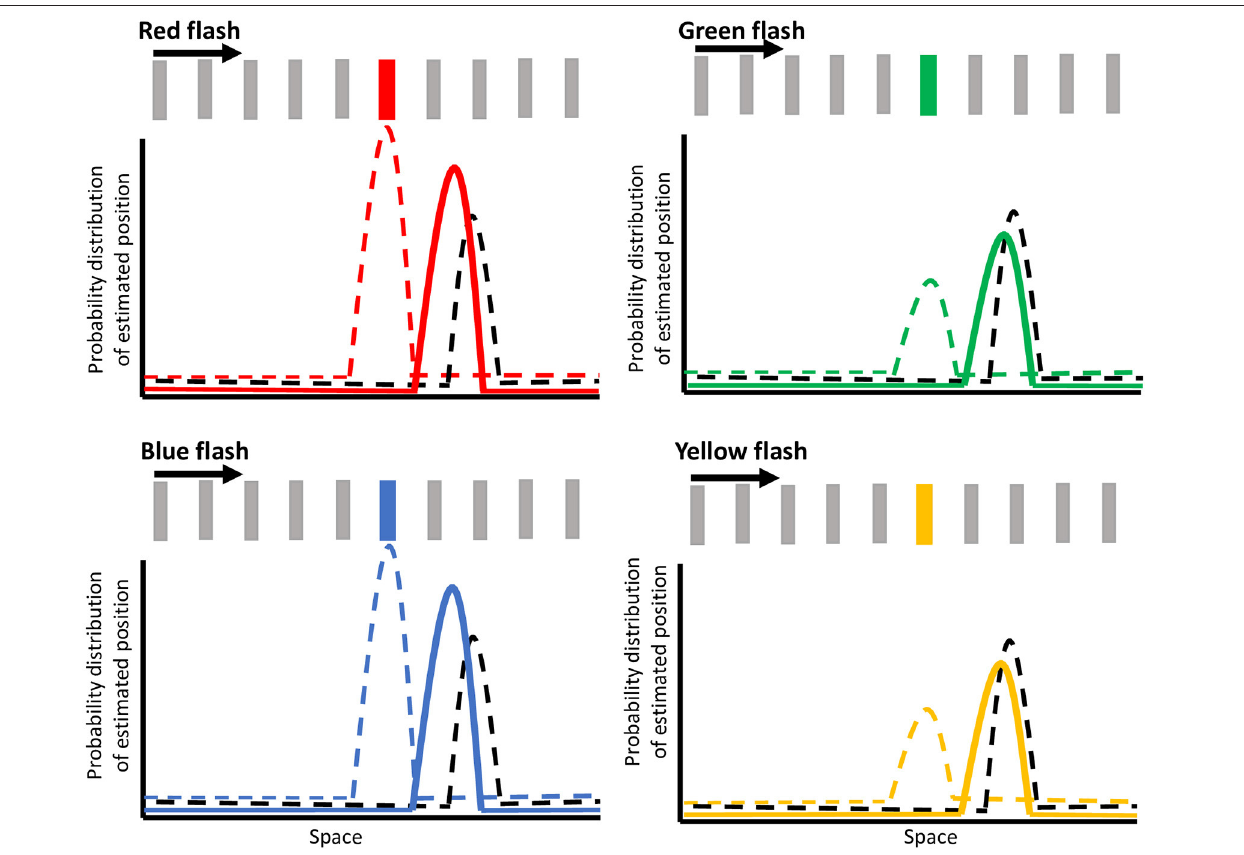
FIGURE 6 | Illustration of the Bayesian model of color modulation. The dashed black curve depicts the motion extrapolation-dependent position representation for the moving bar at the onset of the flash. The dashed colored curve depicts the estimation of the flash location at the onset of the flash for red, green, blue, and yellow flashes, with the height representing the weight of that estimation. The integration of these two signals is depicted by the solid-colored curve, which represents the probability density function for the mislocalization of the flash, as represented by V4 neuronal responses. Note that this illustration depicts the flash-continuing condition with the bar moving in the rightward direction and the spacing between bars has been exaggerated for illustration